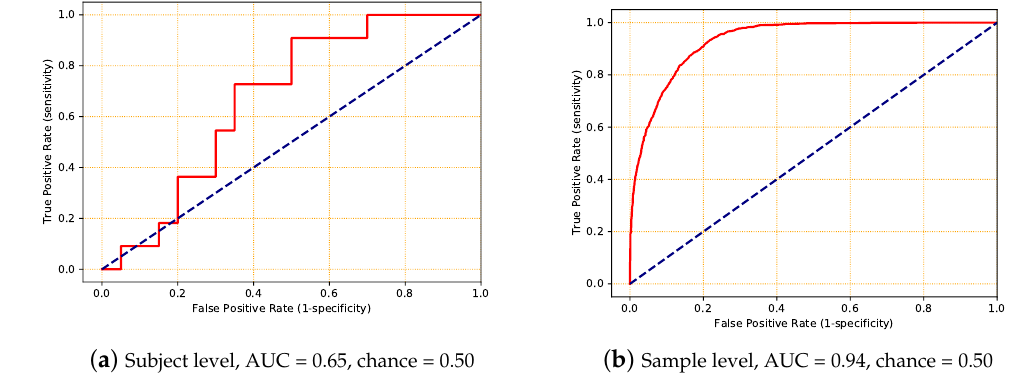
Figure 6. Examples of the receiver operating characteristic (ROC) curves (solid red lines) and their corresponding area under the curve (AUC) values obtained using a ConvLSTM model. The dashed blue line represents the ROC for chance. The dataset was split at ( a ) the subject level and ( b ) the sample